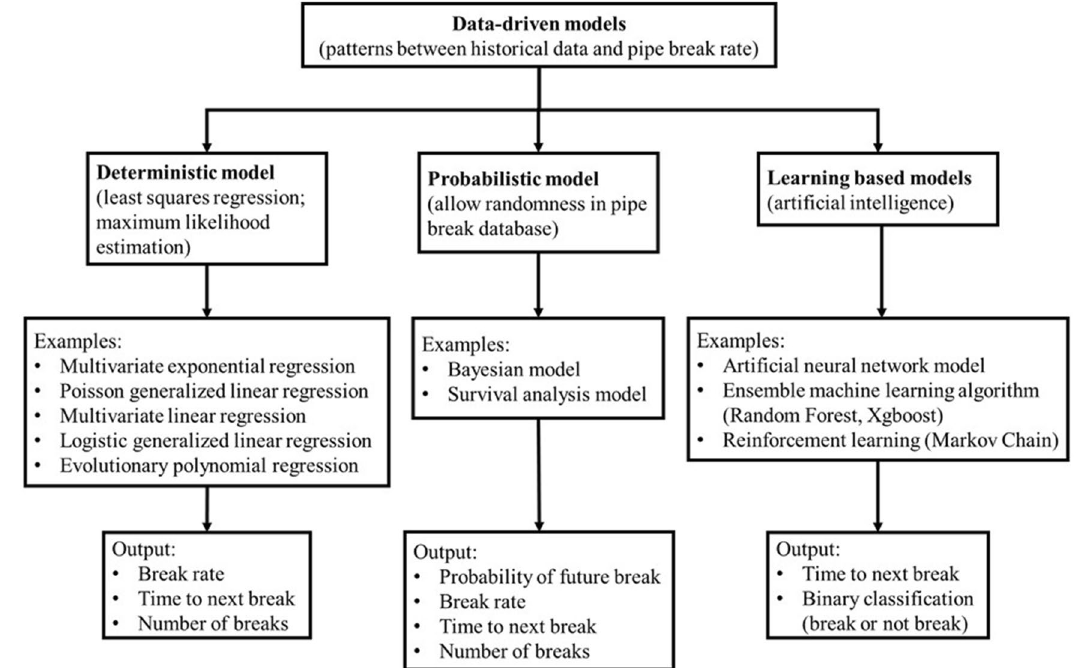
Fig. 1 Classification of water main predictive